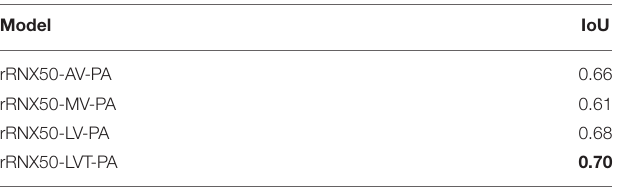
TABLE 6 | Analyzing different voting functions of Chest L-Transformer